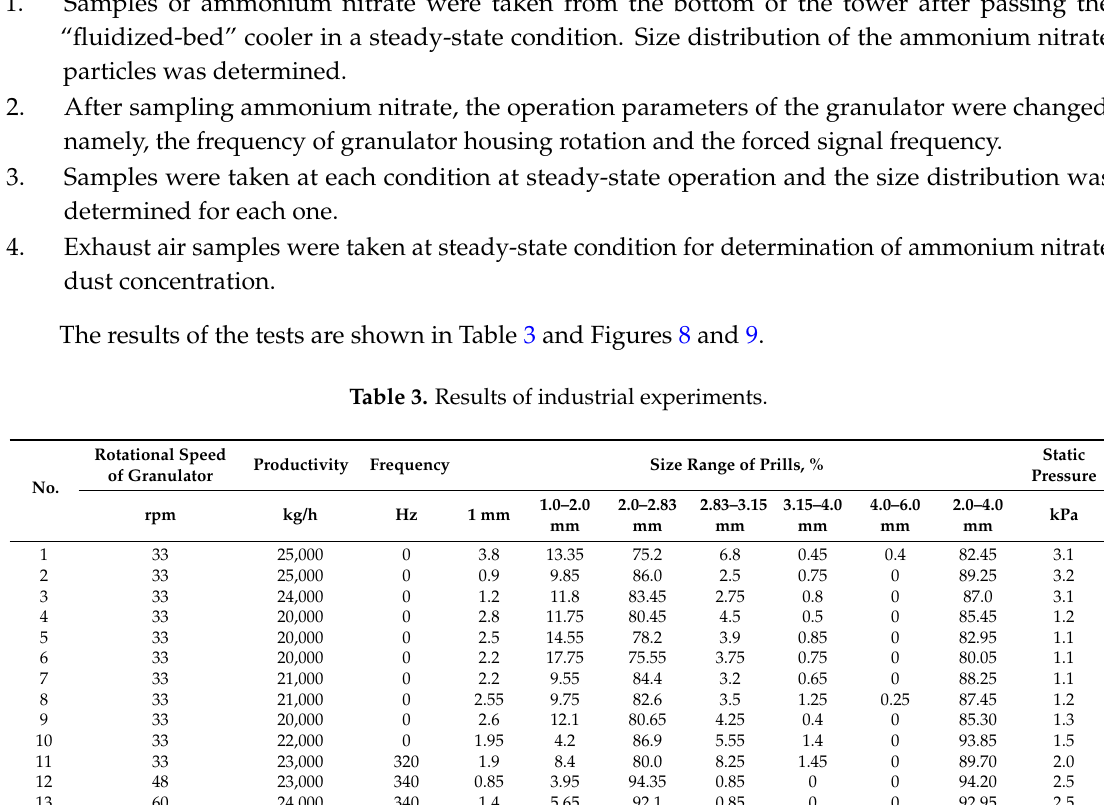
Table 3. Results of industrial experiments.